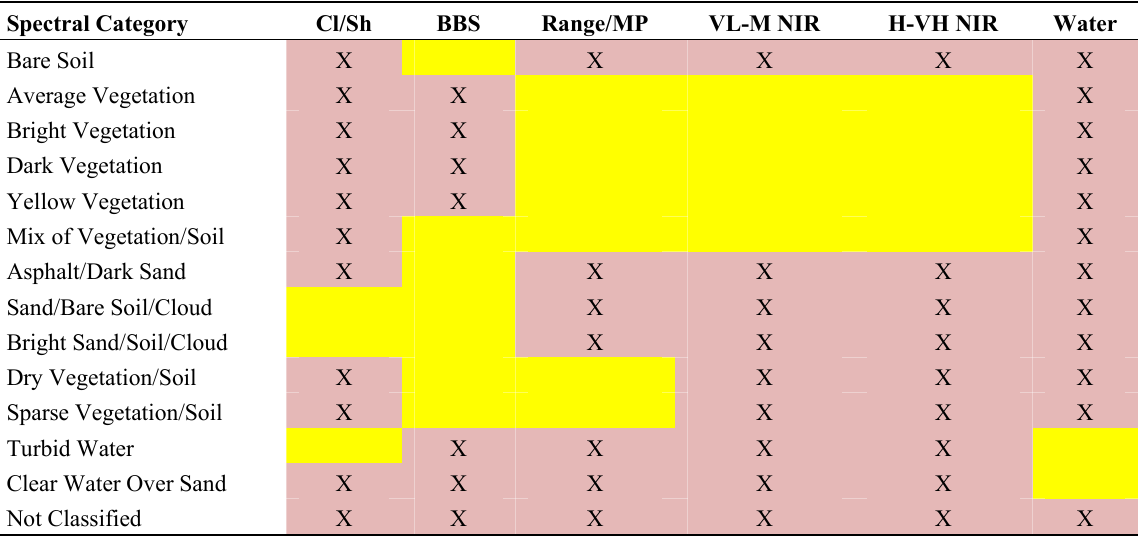
Table 8. ATCOR™-SPECL pre-classification of the IRS test image. Overlapping area